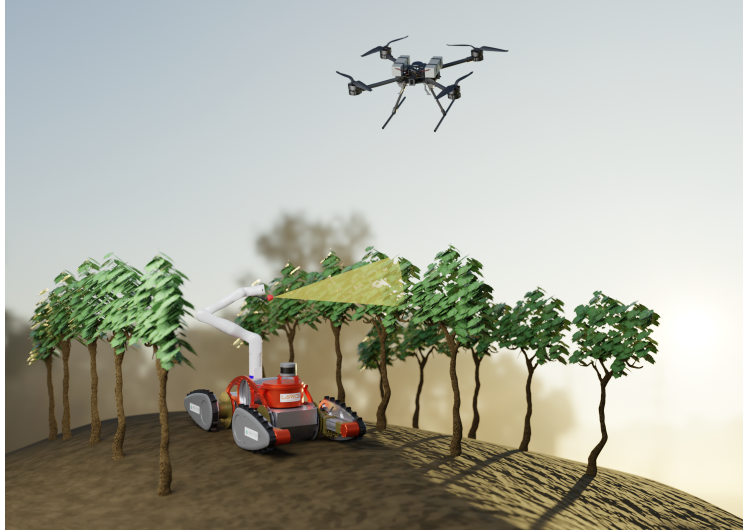
Figure 1. An artist’s view of a heterogeneous robotic system for work in viticulture, consisting of a light autonomous aerial robot and an all-terrain mobile